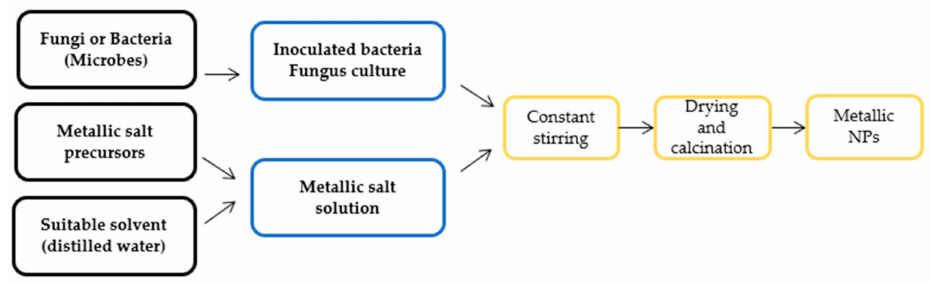
Figure 3. Microbe-mediated synthesis of nanoparticles. Elaboration from Ref.